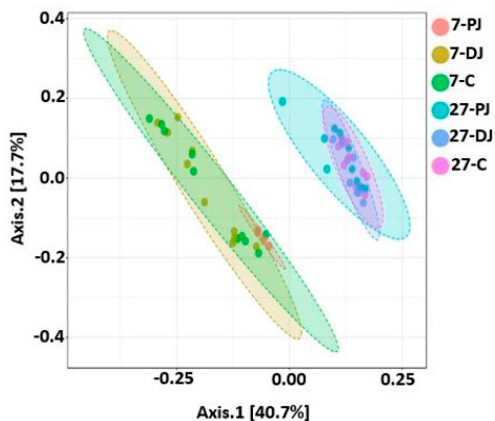
Figure 12. PCoA plot showing significant difference in bacterial community structure in different locations of GIT at two post-weaning ages of piglets (ANOSIM: R = 0.78, p < 0.001 for all four groups; R = 0.86, p < 0.001 for 7 days; R = 0.38, p < 0.001 for 27 days). Unweighted UniFrac distance metric was used to create PCoA plot. The 7 and 27 represent 7 and 27 days, respectively, after weaning; M and D represent mucosa and digesta samples, respectively.